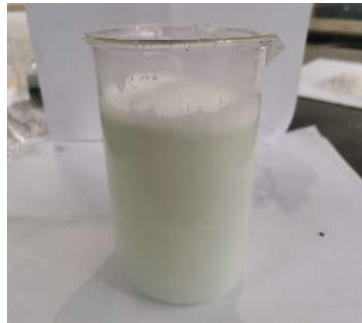
Figure 10. Solid phase particle.